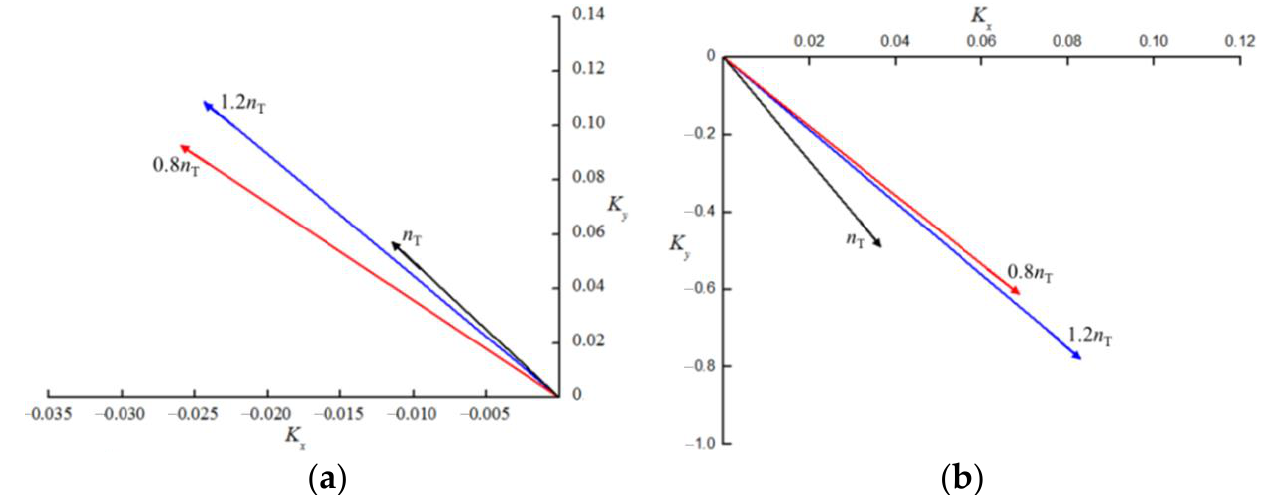
Figure 12. Pressure distributions in the pump.